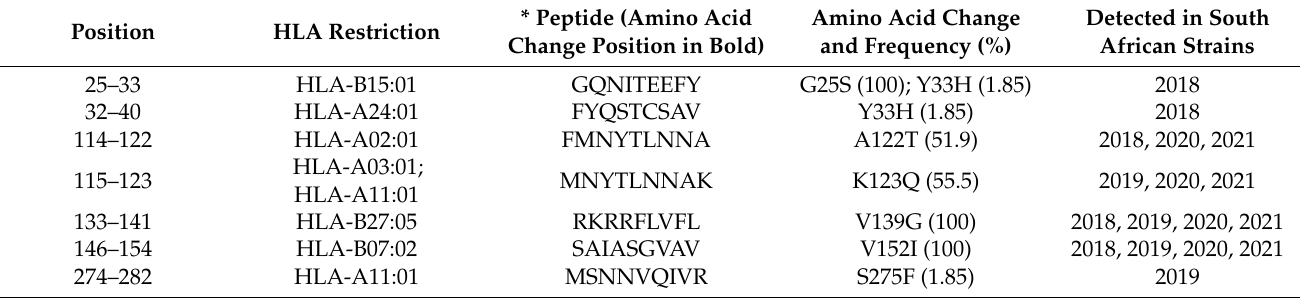
Table 3. CTL escape mutations in predicted RSV F